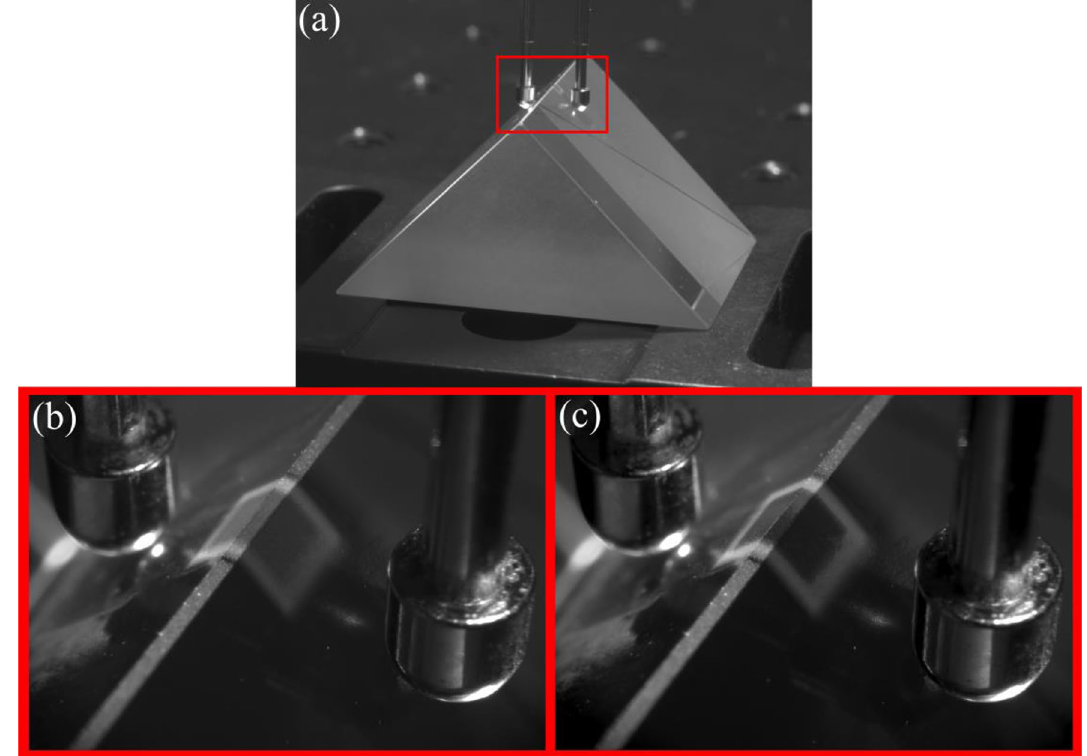
Figure 10. ( a ) A wide view of the prism with the printed device shown for context. The red rectangle represents the area shown in ( b ) and ( c ); ( b ) shows the device in the off-state; ( c ) shows the device in the